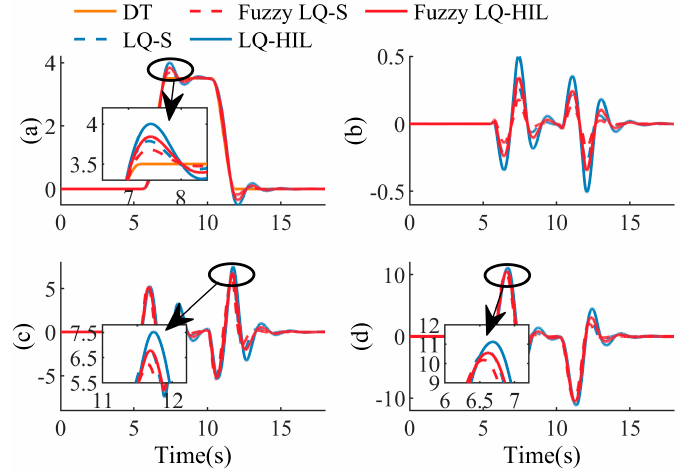
Figure 11. The control effect of double − line − change condition. ( a ) Lateral displacement (m); ( b ) Lateral error (m); ( c ) Front wheel angle (deg); ( d ) Yaw angle (deg).